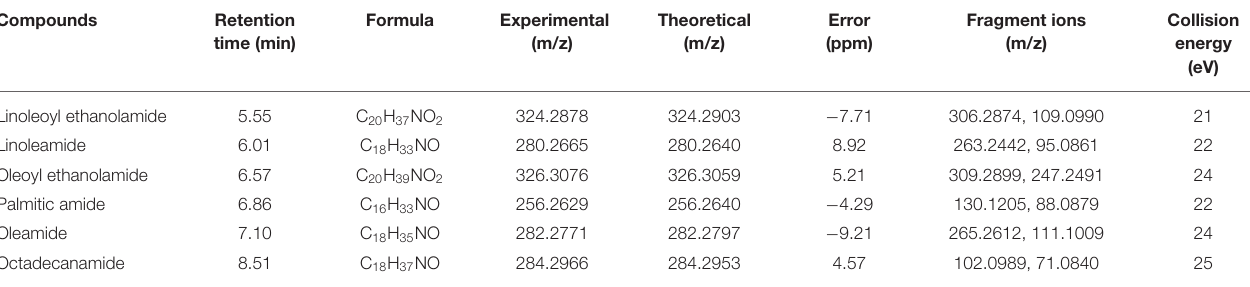
TABLE 1 | The parent ions, qualitative ions and mass spectrum parameters of six fatty acid amides. Compounds Retention